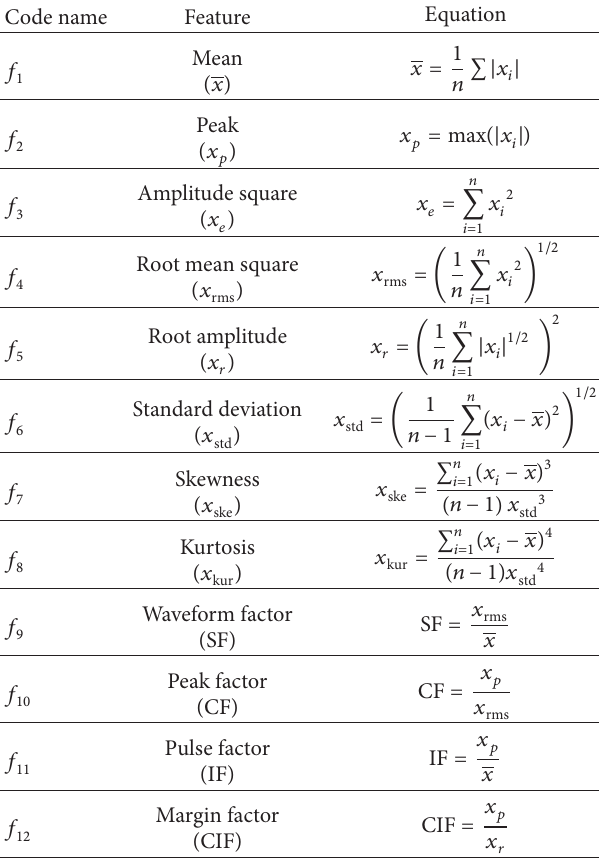
𝑥 𝑖 in the table is discrete time series